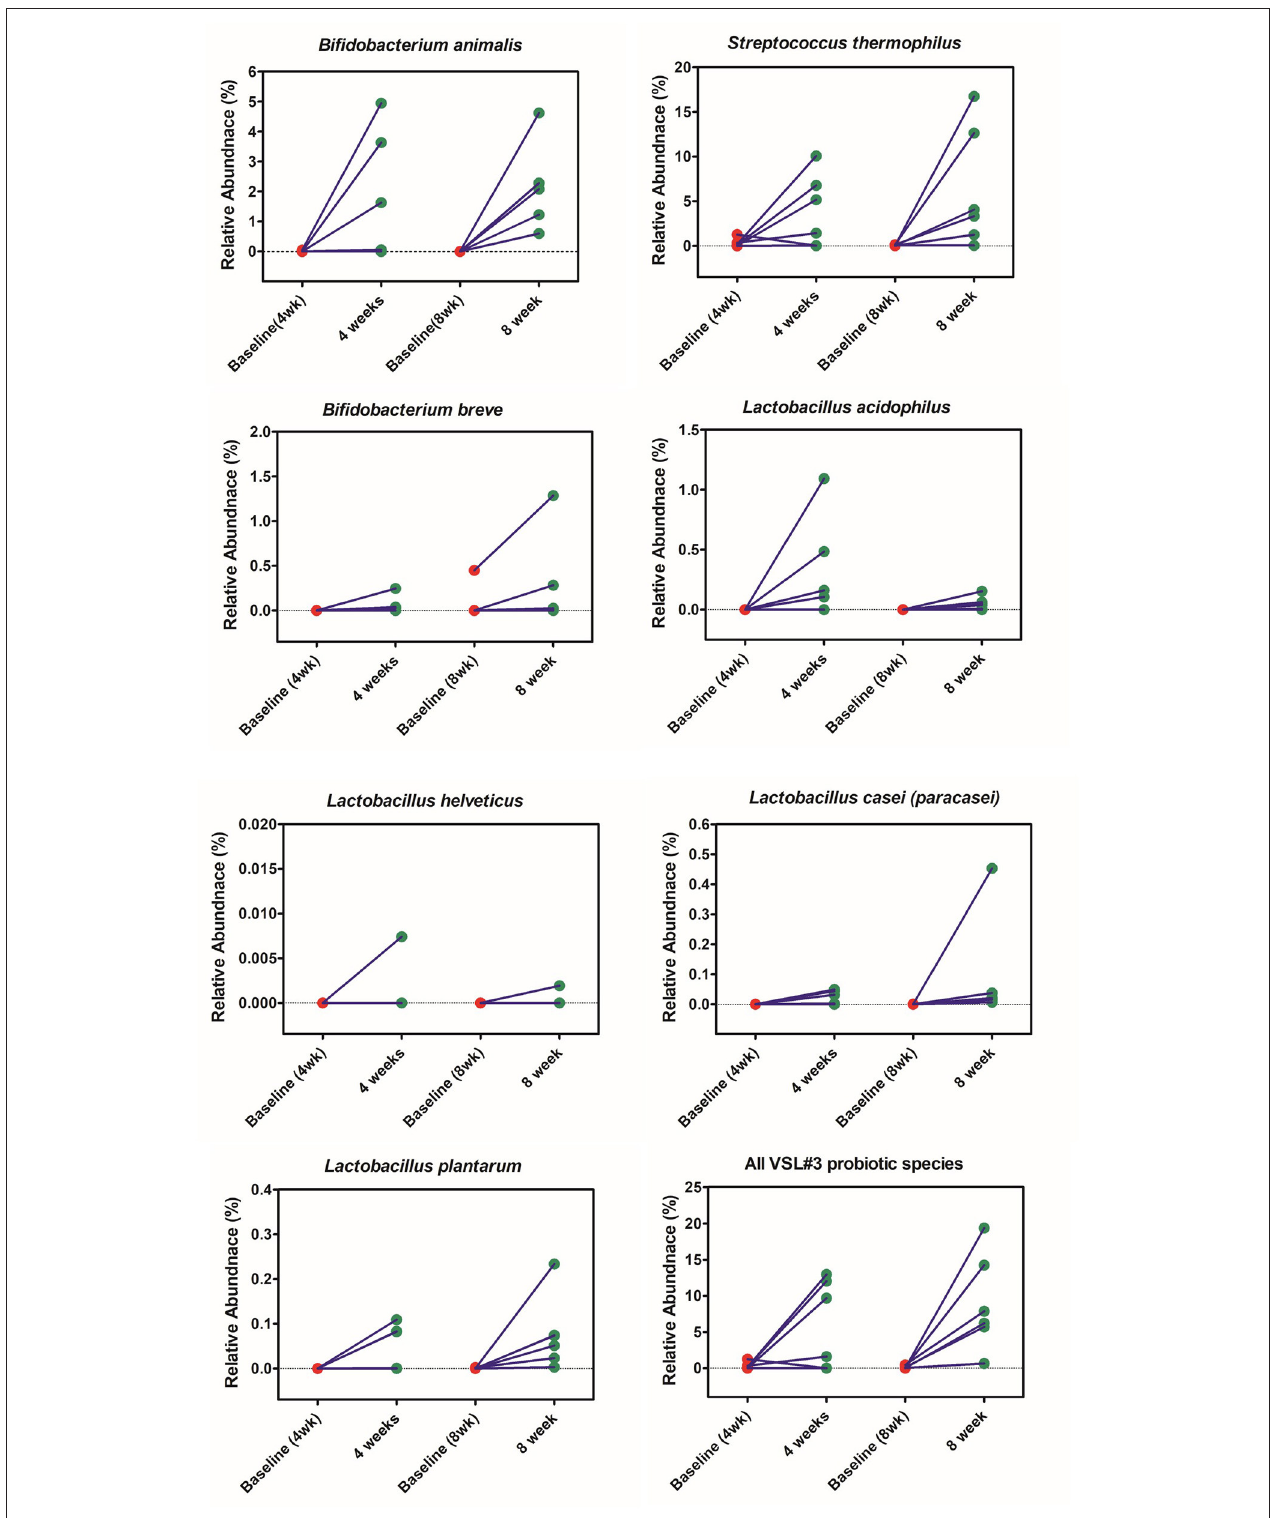
FIGURE 2 | Relative abundance of organisms found in VSL#3 in stool after both 4- and 8-weeks of treatment.